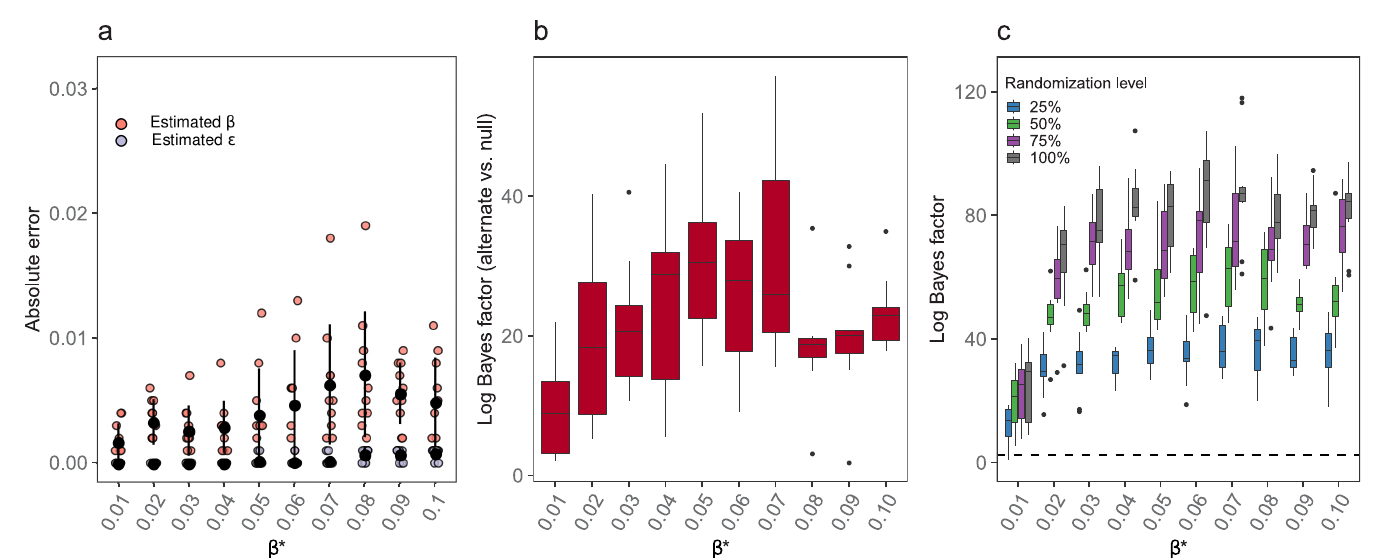
Fig 2. Validation of the three steps of INoDS. (a) Step 1 : Absolute error in estimates of per-contact transmission rate parameter β (orange circles) and background transmission rate � (purple circles) for the simulated dataset with disease transmission rate ( β � ) ranging from 0.01 to 0.1. The true value of background transmission rate ( � � ) is zero. The filled black circle indicates the average absolute error and the error bars indicate standard deviation around the mean value. (b) Step 2 : establishing epidemiological relevance of the observed contact network. Each box summarizes log Bayes factor of observed network compared to null hypothesis (viz a prior of networks with 10% to 100% permuted edges). (c) Step 3 : model selection between the observed contact networks (0% randomization level) and networks with increasing edge randomization (25%, 50%, 75% and 100%). Log Bayes factor was calculated by substracting the log marginal evidence of randomized networks from log marginal evidence of the true (0% randomized) synthetic network. Log Bayes factor of more than 2.44 (dashed line) is considered to be a decisive evidence in favor of the observed contact network. The middle black line in each box plot is the median, the boxed area extends from the 25th to 75th quartile, and whiskers extended from the hinge to the largest/smallest value no further than 1.5 times the inter-quartile